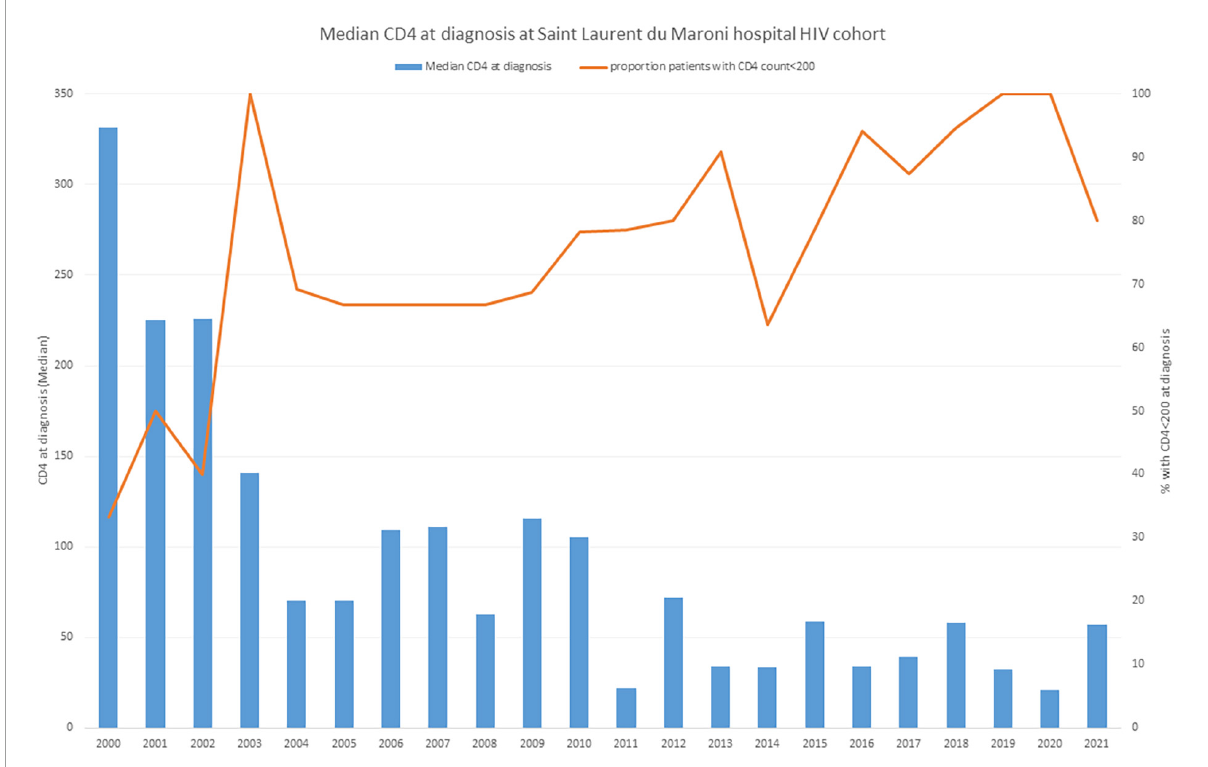
FIGURE4 The median CD4 count at the time of diagnosis in Saint Laurent du Maroni tends to decline over time, with over 70% of new diagnoses with advanced HIV-disease.